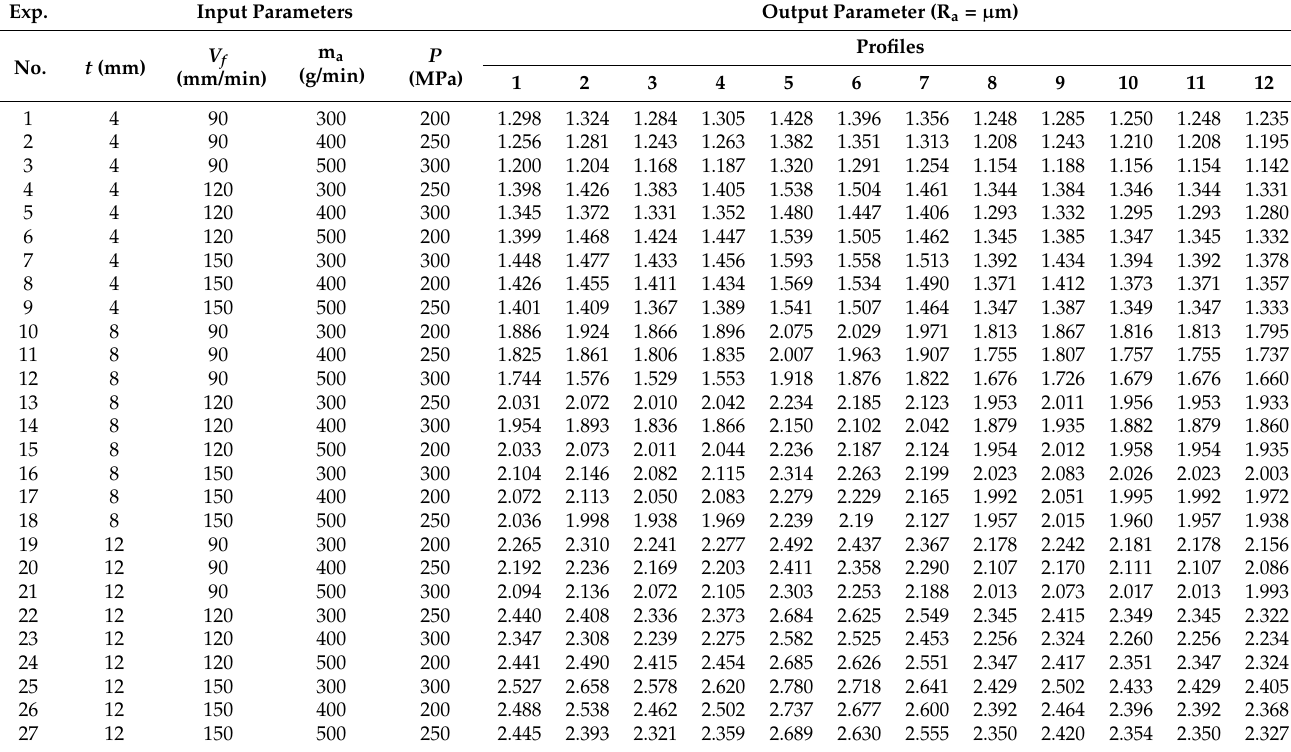
Table 5. The L 27 orthogonal array of Taguchi for surface roughness